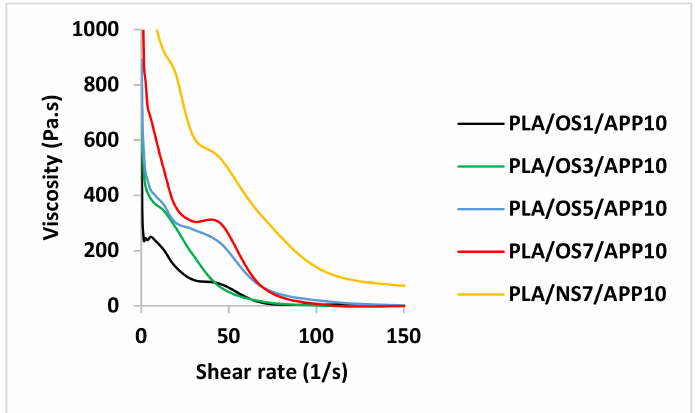
Figure 3. Apparent viscosity of the composite pellets (PLA = polylactic acid; OS = oxidized starch; APP = ammonium